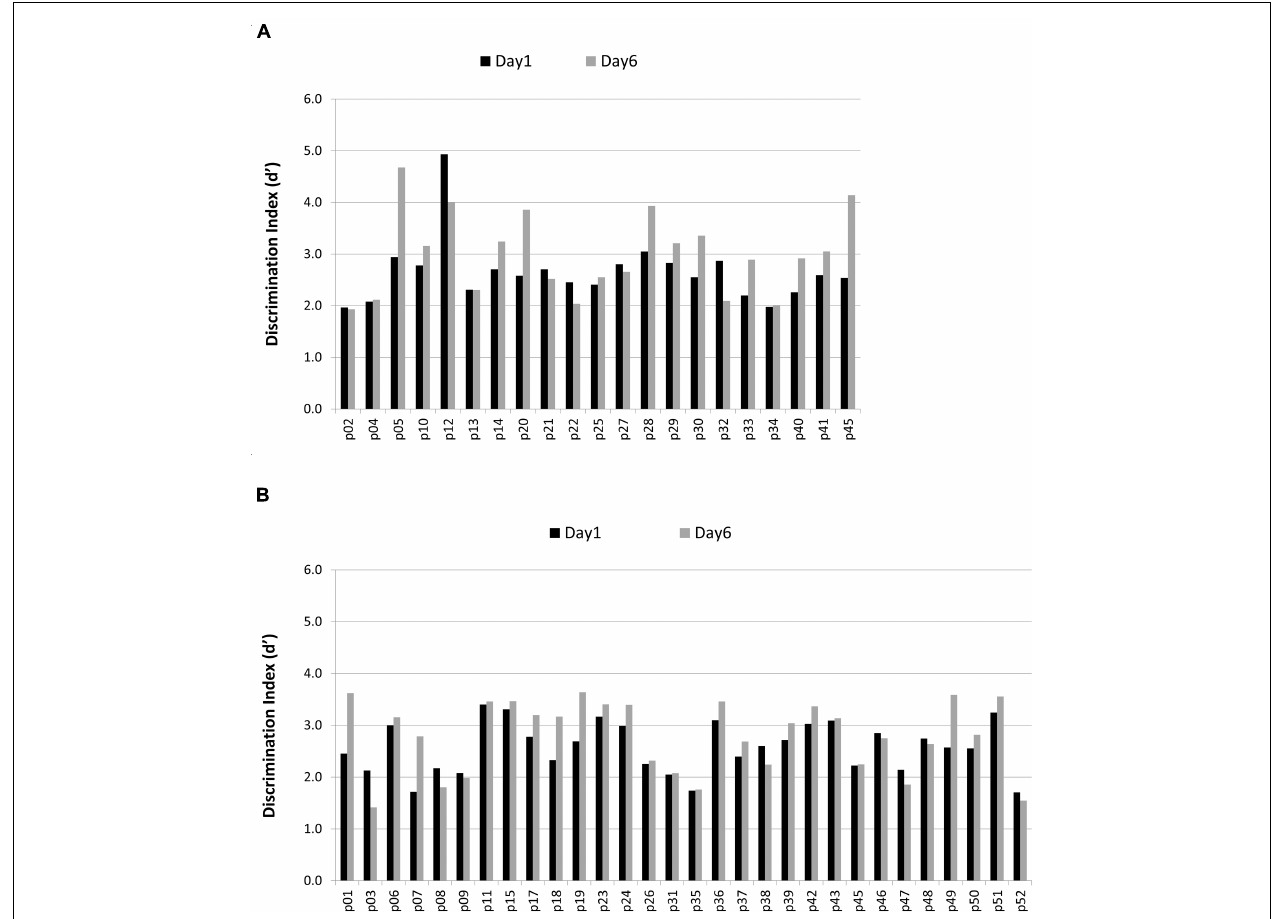
FIGURE 4 | Discrimination Index for each participant in (A) the recognition control group and (B) the recollection training group on Day 1 and Day 6 of training.